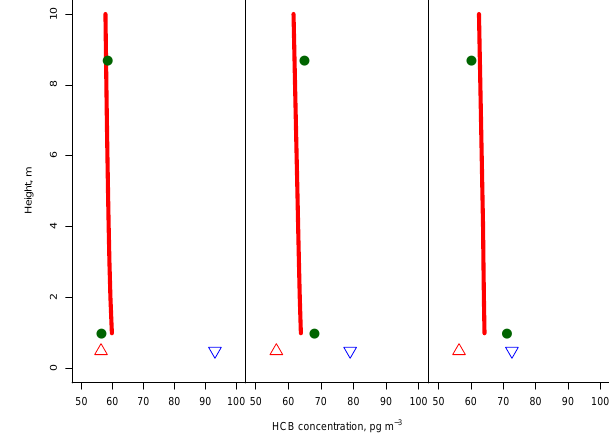
Fig. 5. Measured (circles) and IBLTE-modeled (line) air tempera- ture at the 15-, 30-, and 60-km stations (panels from left to right). The water surface temperature is plotted as a downward-pointing blue triangle, and the initial over-land air temperature as an upward- pointing red triangle.